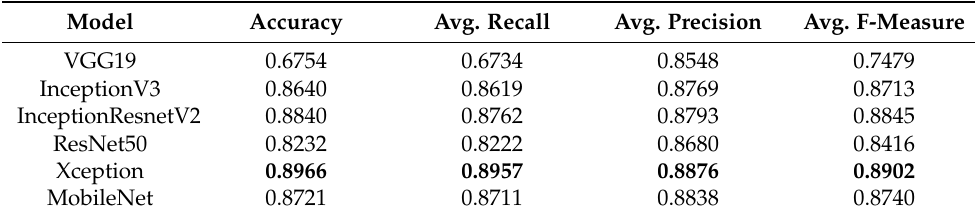
Table 4. Precision, recall, F-Measure, and accuracy values of the models.